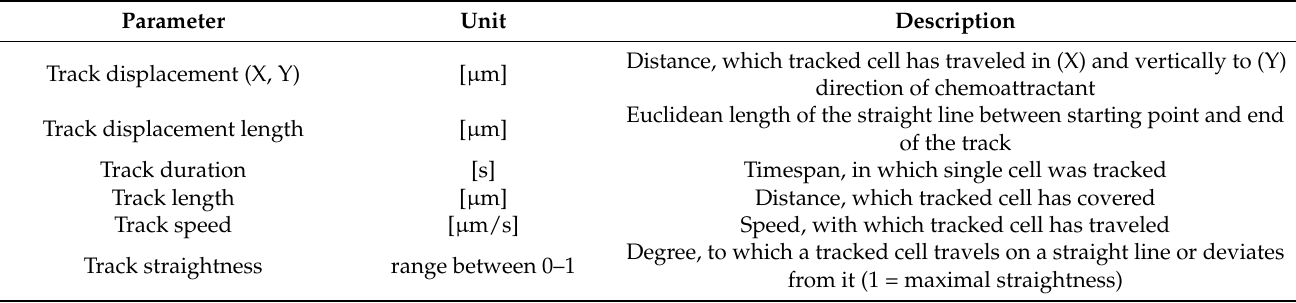
Table 2. Parameters used for examination of neutrophil migration. Parameters are defined according to [5]. Parameter Unit Description Distance, which tracked cell has traveled in (X) and vertically to (Y) Track displacement (X, Y) [ µ m] direction of chemoattractant Euclidean length of the straight line between starting point and end Track displacement length [ µ m] of the track Track duration [s] Timespan, in which single cell was tracked Track length [ µ m] Track speed [ µ